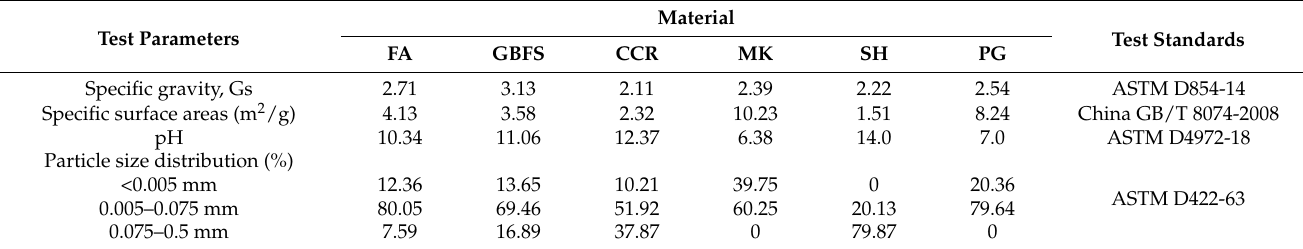
Table 2. Basic physicochemical properties of matrix material of waste-based binder.